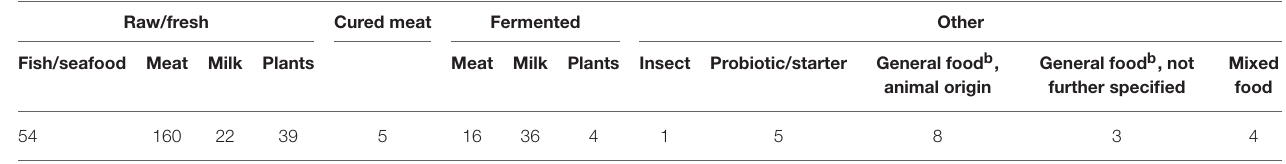
TABLE 2 | Overview of food product categories address by the studies included for qualitative and quantitative analysis a . Raw/fresh Cured meat Fermented Other Fish/seafood Meat Milk